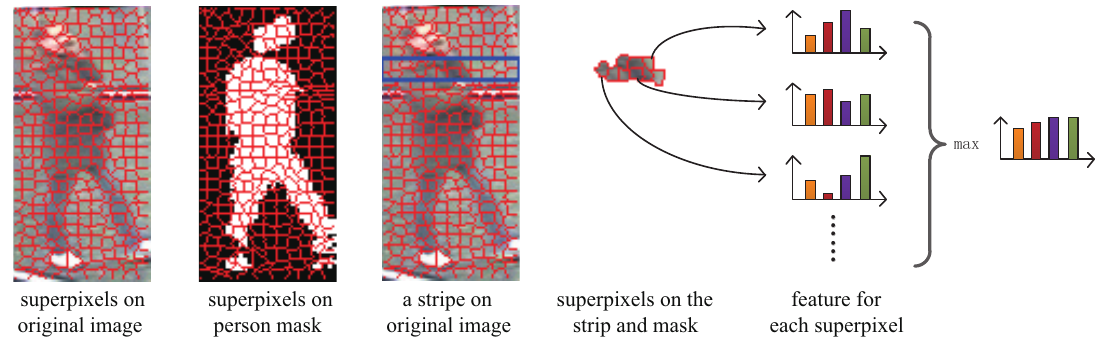
Figure 6. Illustration of the superpixel based